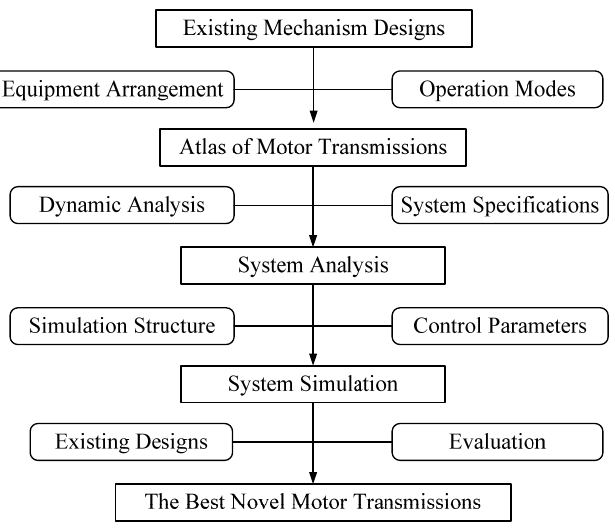
Figure 2. The design procedure.